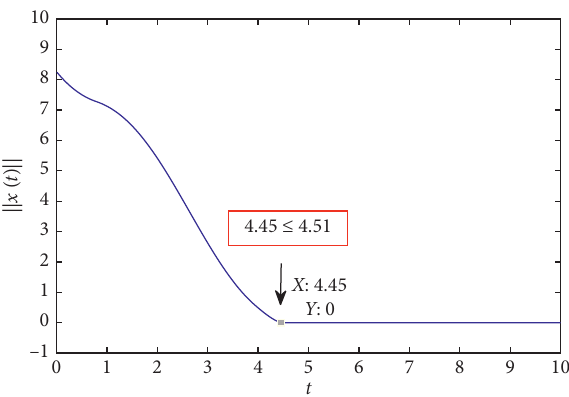
Figure 1: Simulation results of states for system (26).